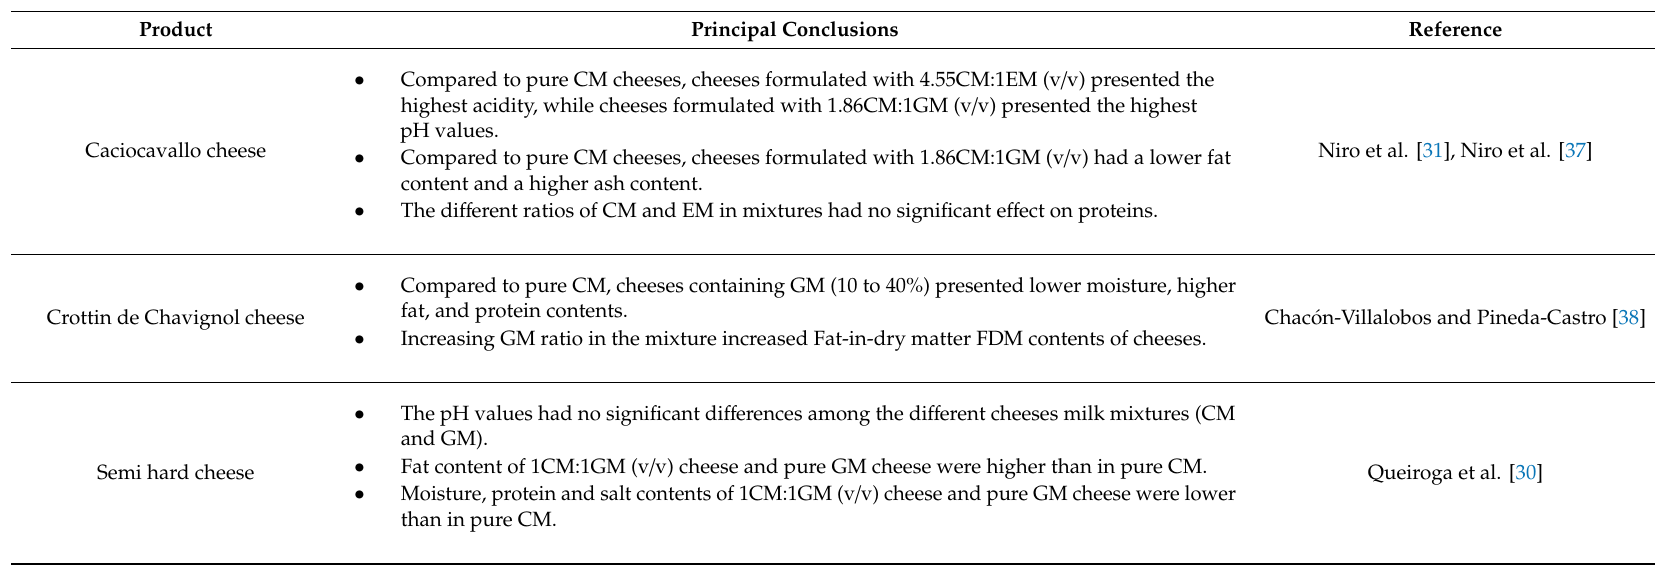
Table 2. Examples of principal conclusions of studies concerning the e ff ect of mixing milk from di ff erent species at di ff erent proportions on physicochemical and biochemical properties of cheeses 1